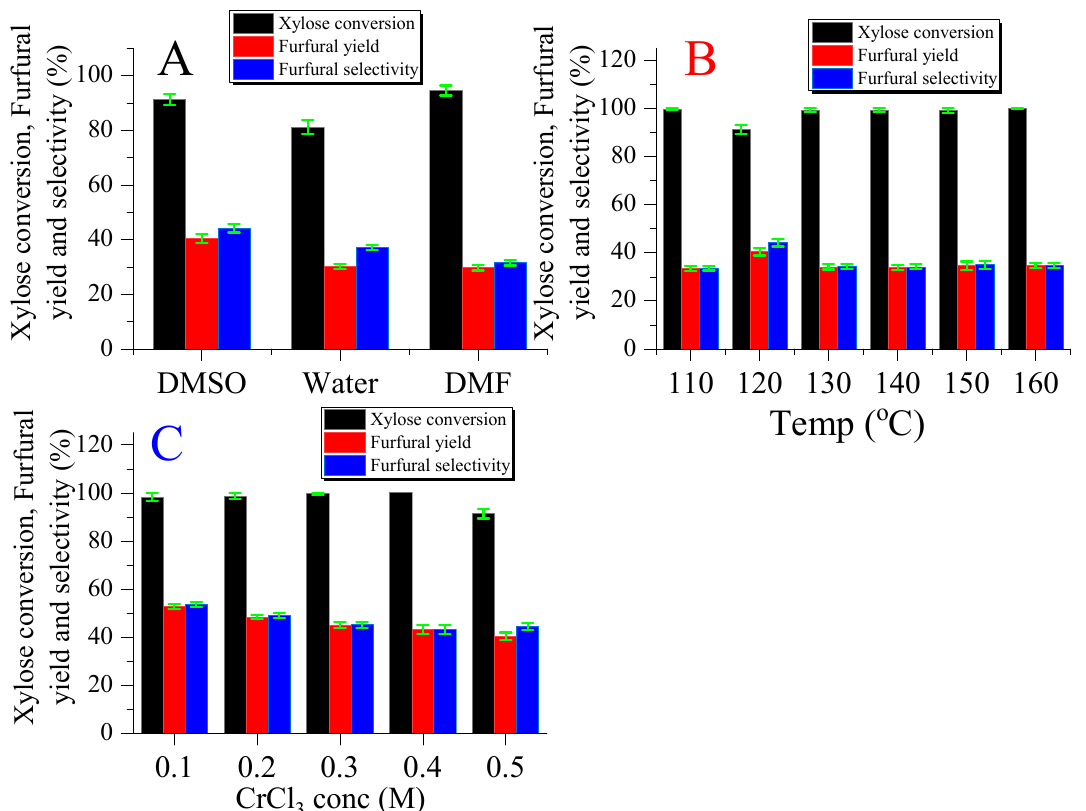
Figure 2. Xylose dehydration into furfural. Reaction conditions: ( A ) 0.5 M xylose, 1.0 M p TSA, and 0.5 M CrCl 3 .6H 2 O in 50 mL solvents heated at 120 °C (for water 100 °C), ( B ) 0.5 M xylose, 1.0 M p TSA and 0.5 M CrCl 3 .6H 2 O in 50 mL DMSO heated at different temperatures, ( C ) 0.5 M xylose, 1.0 M p TSA and different concentrations of CrCl 3 .6H 2 O in 50 mL DMSO and 120 °C.